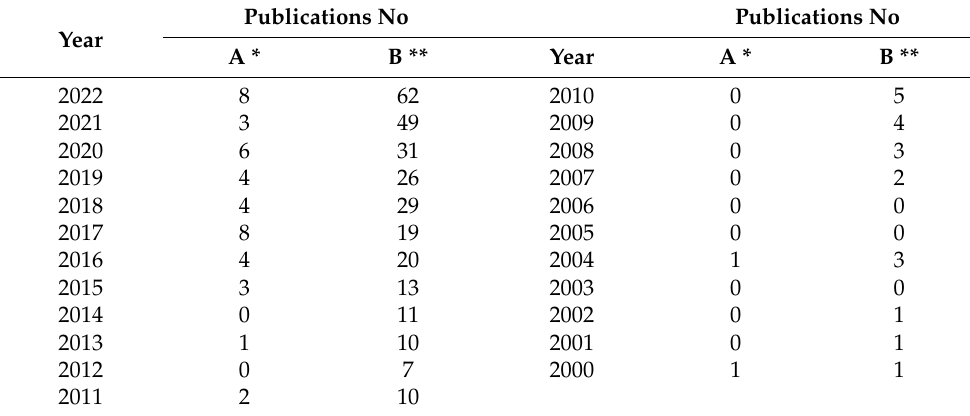
Table 2. Annual number of publications since 2000 using as keywords saffron and authenticity and saffron and health in the title, abstract, or keyword fields (Scopus search carried out in January